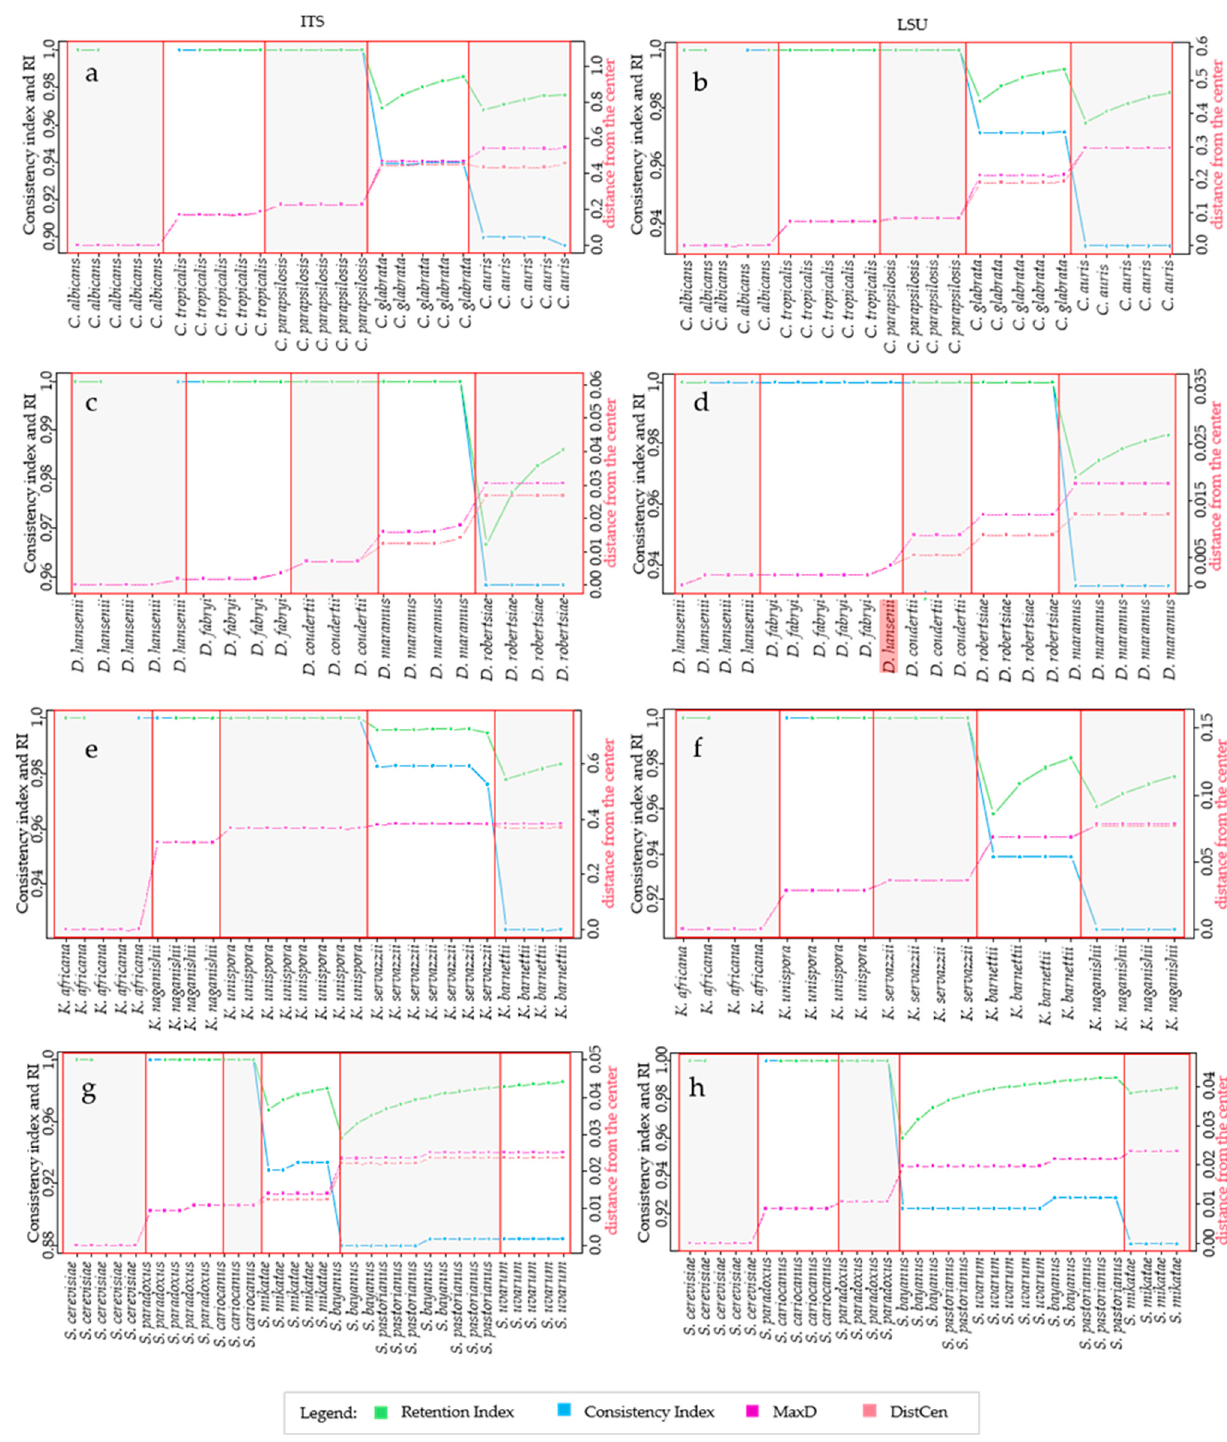
Figure 5. Variation of Homoplasy and phenetic Distances within different clades, at strain level. For every strain added to the series, the algorithm calculates the following metrics: MaxD (purple line), DisCen (red line), Consistency index (blue line), Retention index (green line). All these values were calculated considering different strains for every species included in the analysis. Plots show metrics obtained from ITS and LSU sequence alignment of different strains within Candida clade, respectively in ( a , b ); ITS and LSU data from strains of Debaryomyces in ( c , d ); Kazachstania , panels ( e , f ); Saccharomyes clade, ( g , h ). In general, CI is stable at its maximum = 1 with three species. Upon addiction of the first strain of the fourth species, CI decreases and remain stable until strains of the fifth and following species are added.